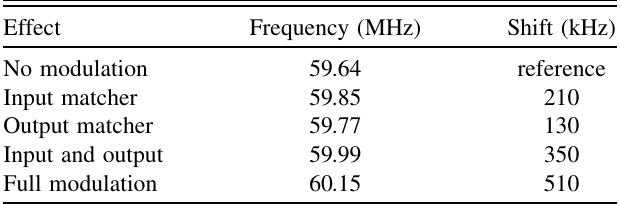
TABLE XV. Effect of the different parts of vane modulation on the frequency.